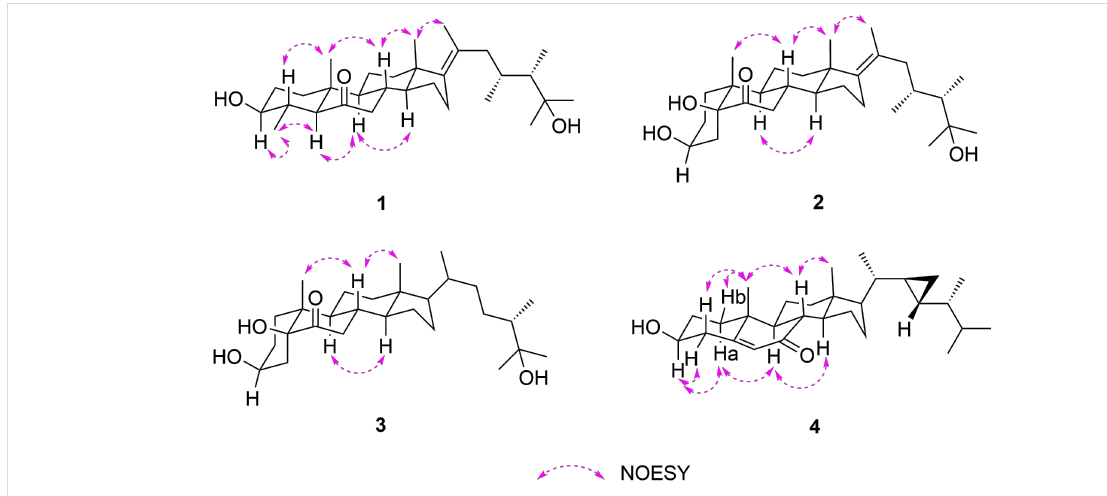
Figure 3: Selected NOESY correlations of compounds 1 – 4 .